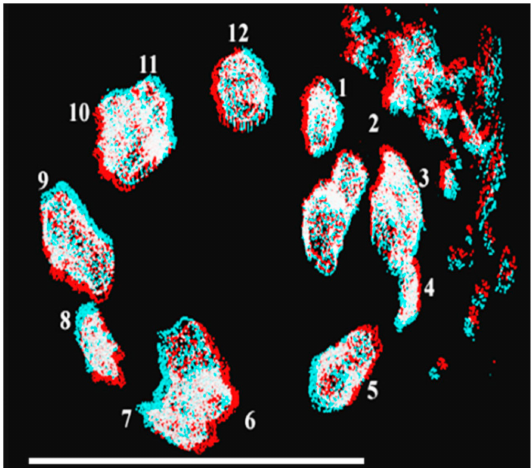
Figure 11. Anaglyph-transmission electron microscopy visualization of garden snail ( Helix pomata ) chromosomes. Numbered (1–12) haploid chromosomes of type B spermatogonia. The